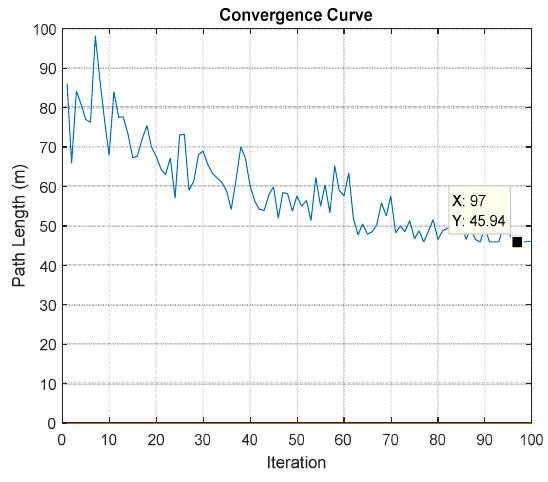
Fig. 15. The Convergence Curve for Experiment 3 .